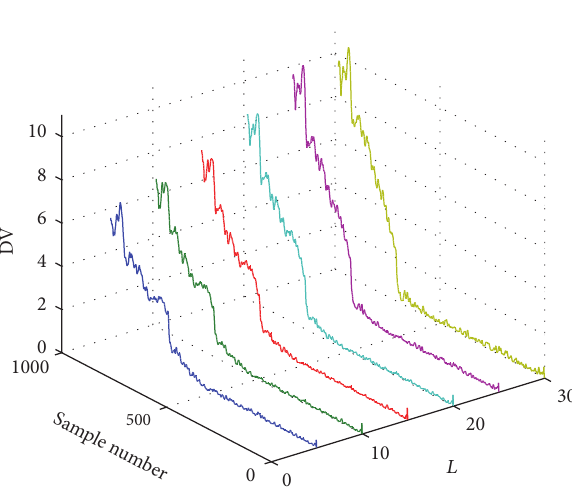
Figure 9: Assessment result with different values of 𝐿 .